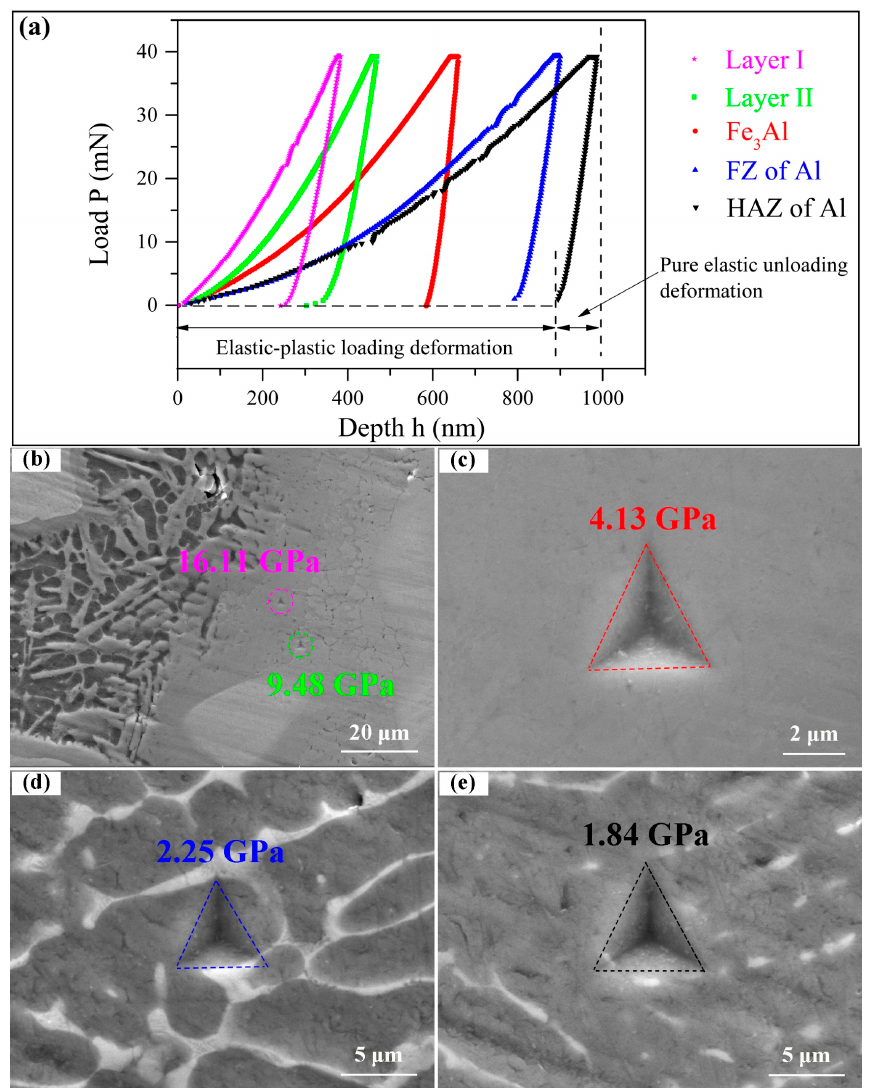
Figure 8. Nanohardness of the welded joint. ( a ) Load–depth (P–h) curves and ( b – e ) corresponding images of indentation in all of the individual regions.